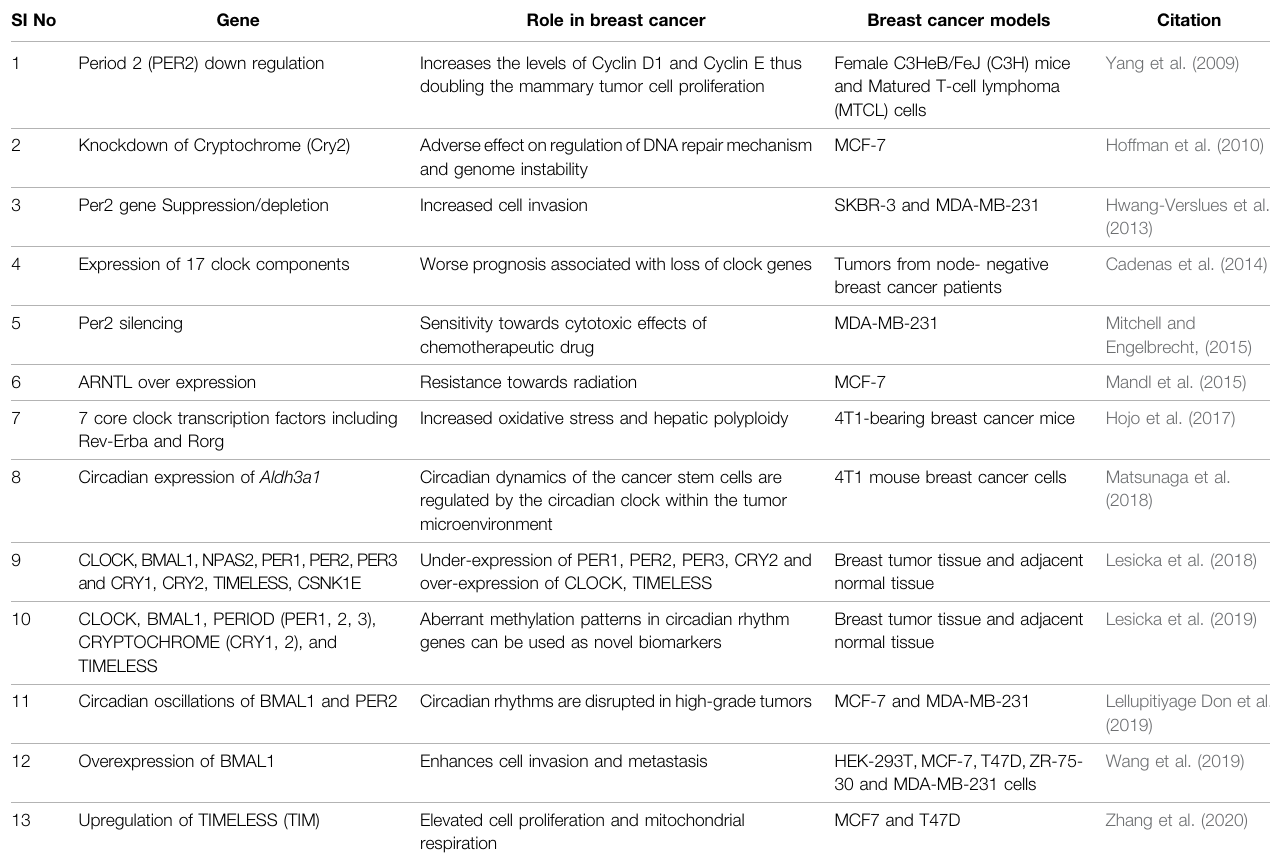
TABLE 1 | Core clock genes and their association with breast cancer